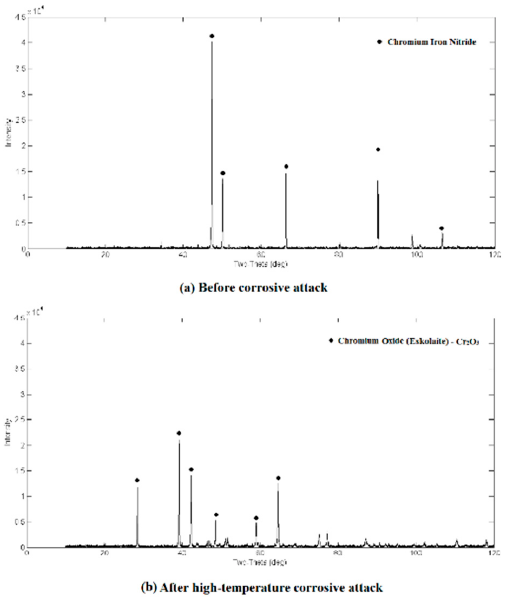
Figure A28. Qualitative XRD analysis of the surface of CS-Cr ( a ) before corrosive attack, ( b ) after high-temperature corrosive attack.